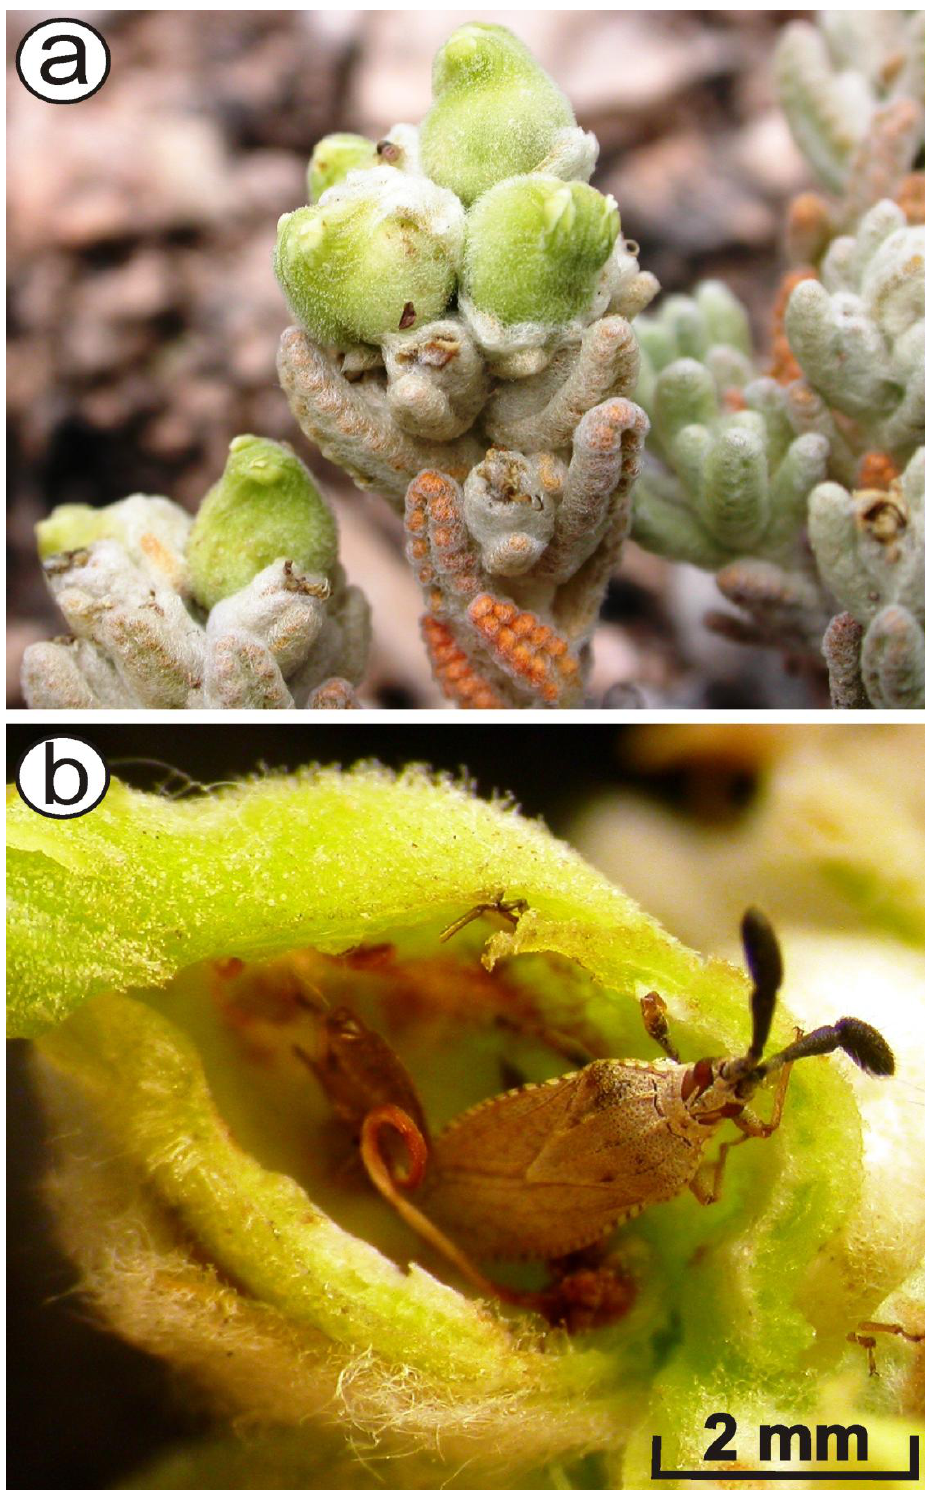
FIGURE 1. (a) Vegetable galls induced in Teucrium flowers by the Copium insect (Torrelaguna, Northern Madrid, Spain); (b) adult Copium insects are totally formed in the interior of galls and get outside by drilling a hole in the gall